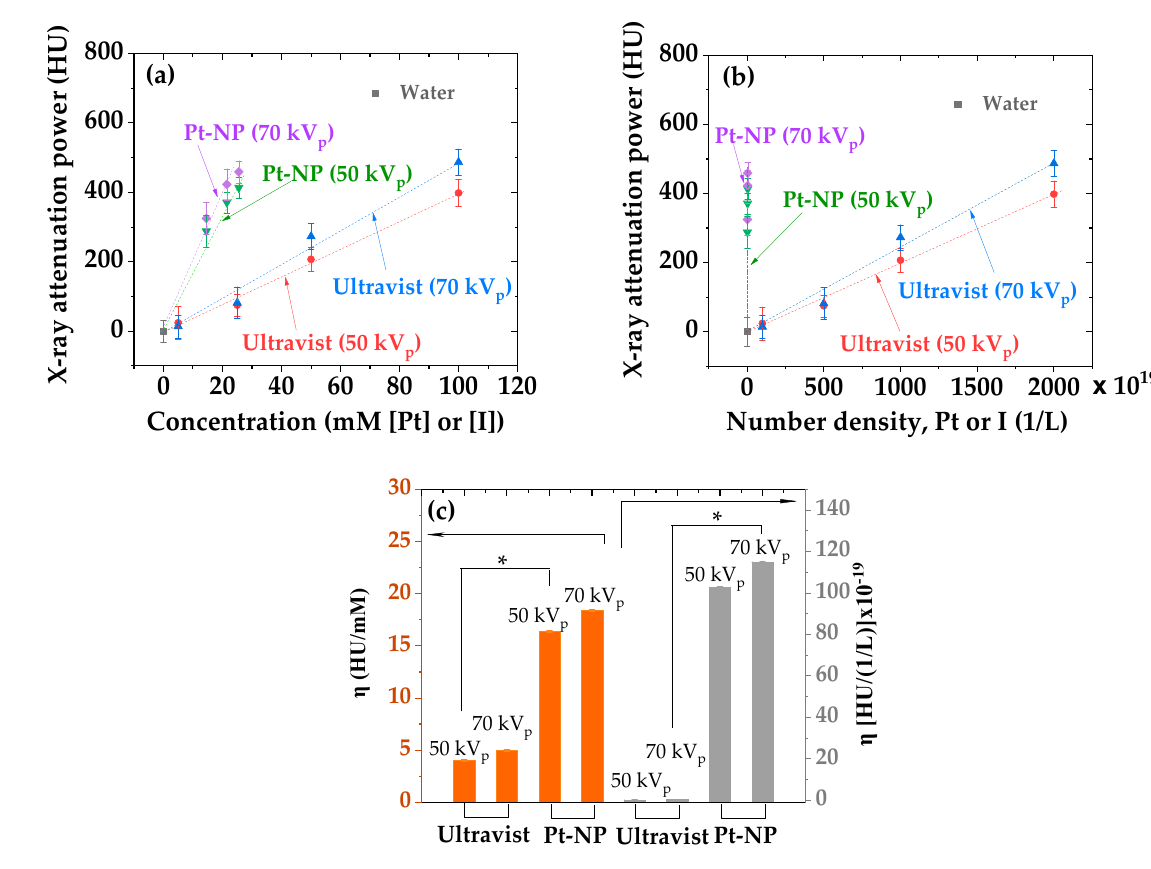
Figure 9. Plot of X-ray attenuation power as a function of ( a ) atomic concentration and ( b ) number density: the dotted lines indicate slopes [i.e., X-ray attenuation efficiency ( η )]. ( c ) Plot of η of polymer-coated Pt-NPs and Ultravist in HU/mM (left) and HU/(1/L) (right) (X-ray source voltages, 50 and 70 kV p ): (*: p * < 0.05, the significance of the results was confirmed using a t -test). Table 4. Summary of the X-ray attenuation properties at 50 and 70 kV p .